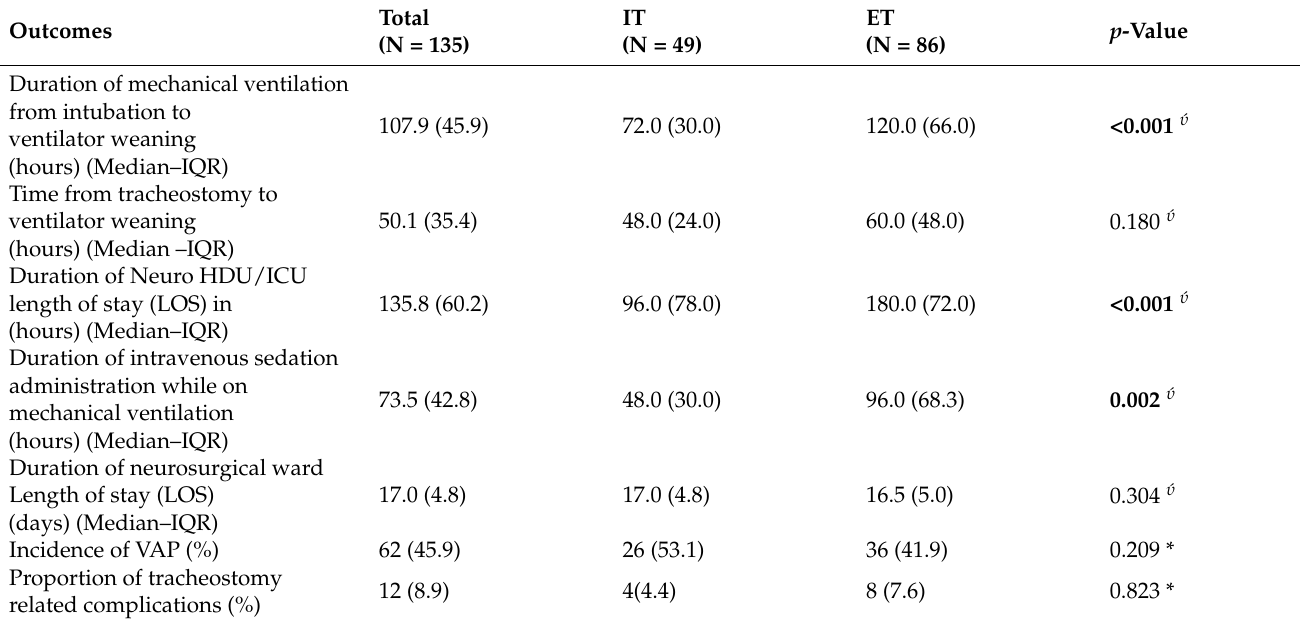
Table 2. Outcomes of patients who underwent Immediate Tracheostomy (IT) and Early Tracheostomy (ET) after decompressive craniectomy